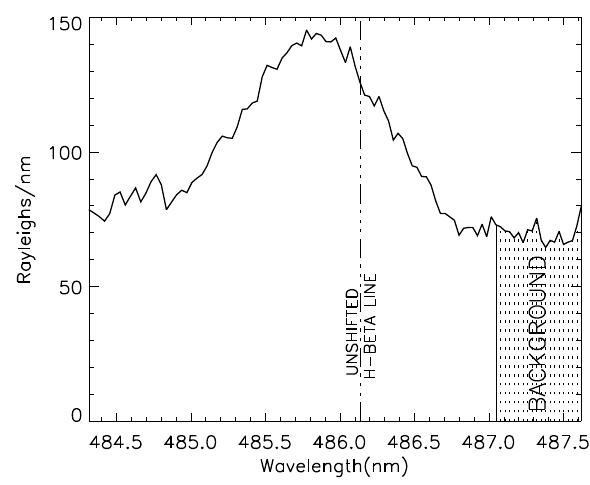
Fig. 2. Spectrum ( T (λ) ) recorded by HiTIES between 08:45 UT and 10:01 UT on 30 November 2002.